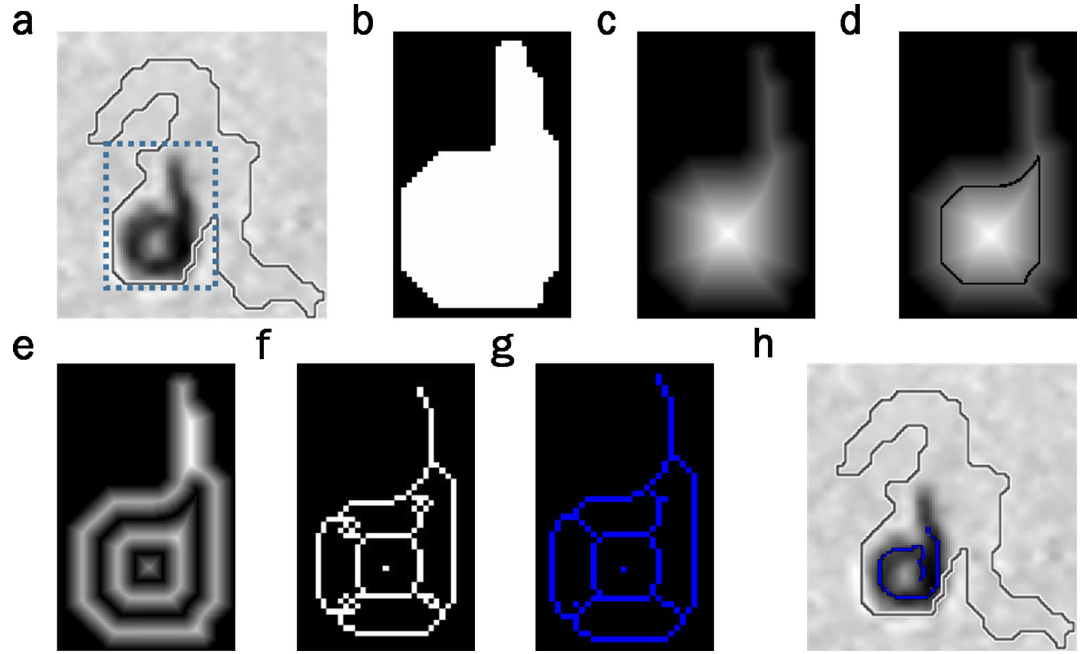
Figure 6. Example of a track of a rolled worm. Proposed method steps. ( a ) Subimage containing the current connected region. ( b ) Segmentation of the current subimage. ( c ) Distance transform. ( d ) Background transform by using the minimum width value. ( e ) Second iteration of the background transform. ( f ) Skeleton with holes. ( g ) Final skeleton. ( h ) Optimisation result.